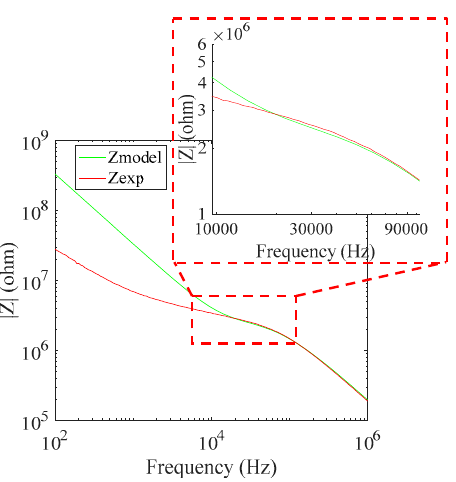
Figure 14. The impedance spectrum of the electrical model (green) and the experimental results (red) of 20 × 20 µm² electrodes with 10 µm electrode connection track lengths in solution.